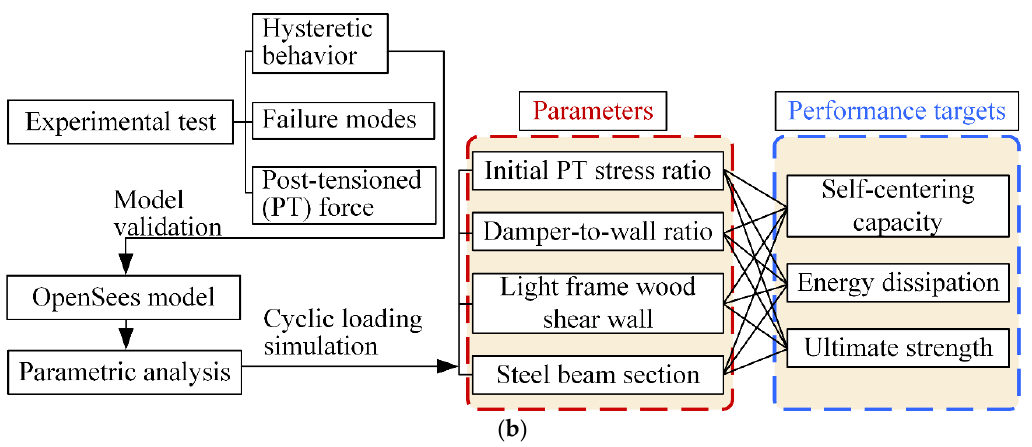
Figure 1. ( a ) Self-centering steel – timber hybrid shear wall (SC-STHSW); and ( b ) the flow chart of the research approach.